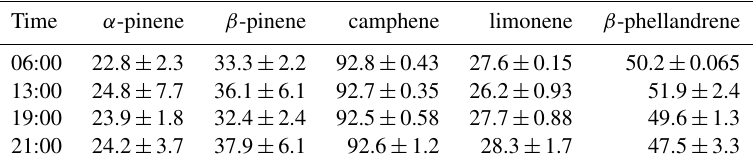
Table 4. Percent ( − )-enantiomer values ± 1 standard deviation (SD) for five chiral monoterpenes in Thuja occidentalis in four nursery- purchased plants located at PSU sampled once each ( N = 4) in March 2018 and once each in June–July 2018 (see also Fig. 4). Time α -pinene β -pinene